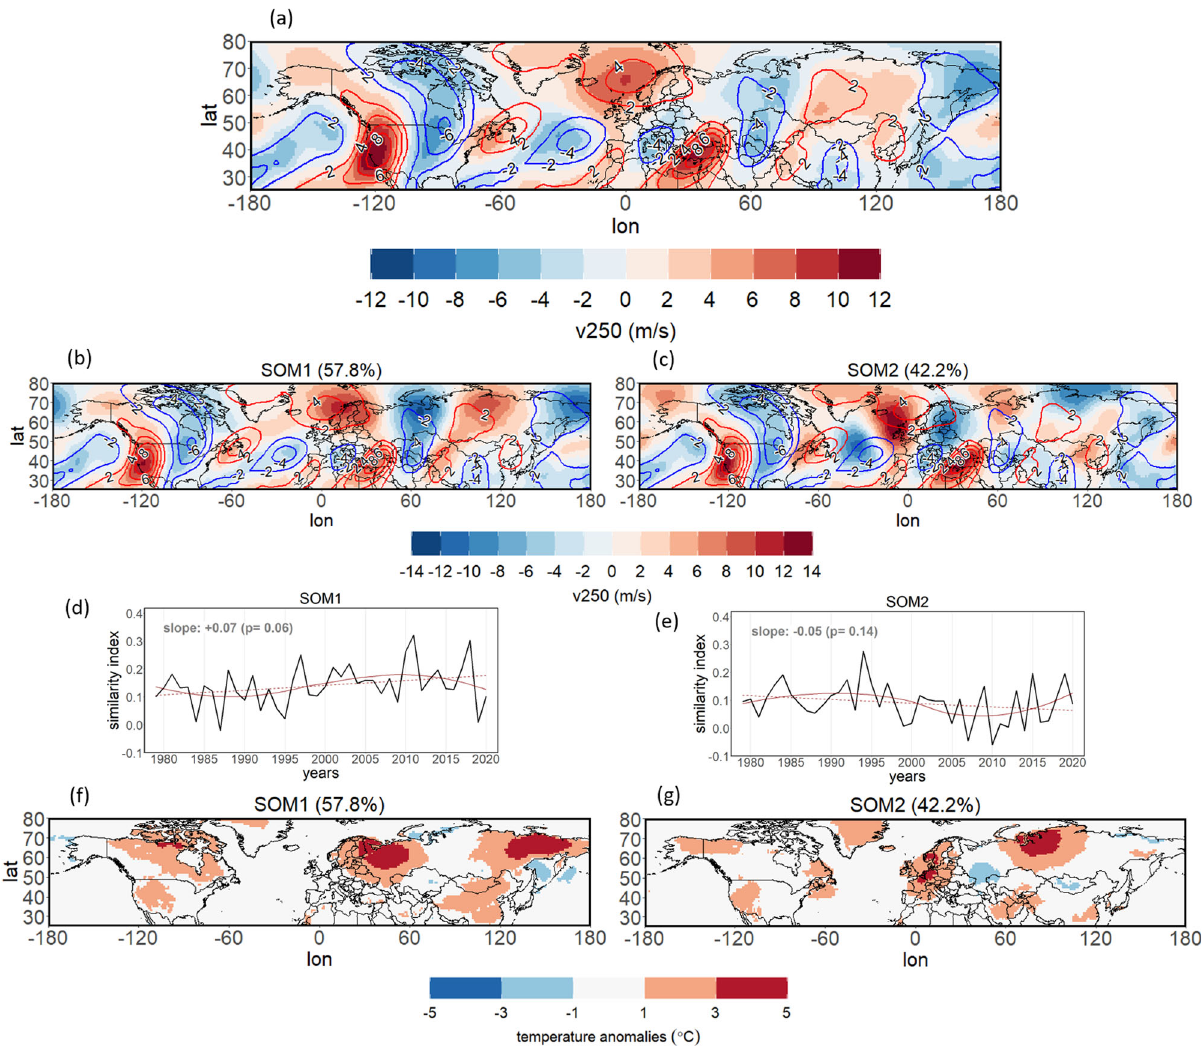
Fig. 3 Persistent double jets states. a Composite of meridional winds at 250hPa (v250) for double jet events exceeding the 90th percentile of double jet persistence (i.e, events lasting more than 11 consecutive days, see Table S1 for the 20 most persistent events and their duration; shading). Contour lines show the v250 July-August climatology for the whole period 1979 – 2020 (plotted from − 5 to 8 m/s every 2 m/s). b , c SOM cluster composites of v250 for persistent double jet events (frequency % of each SOM is shown in parenthesis). d , e Time series of daily similarity index for the two SOMs of v250 winds. The red dashed line shows a linear regression fi t, with its slope and p-value plotted on the top left. The continuous red line shows a smoothed LOESS curve fi t (span of 0.75). f , g Anomaly composites of (linearly detrended) mean surface temperature for each of the